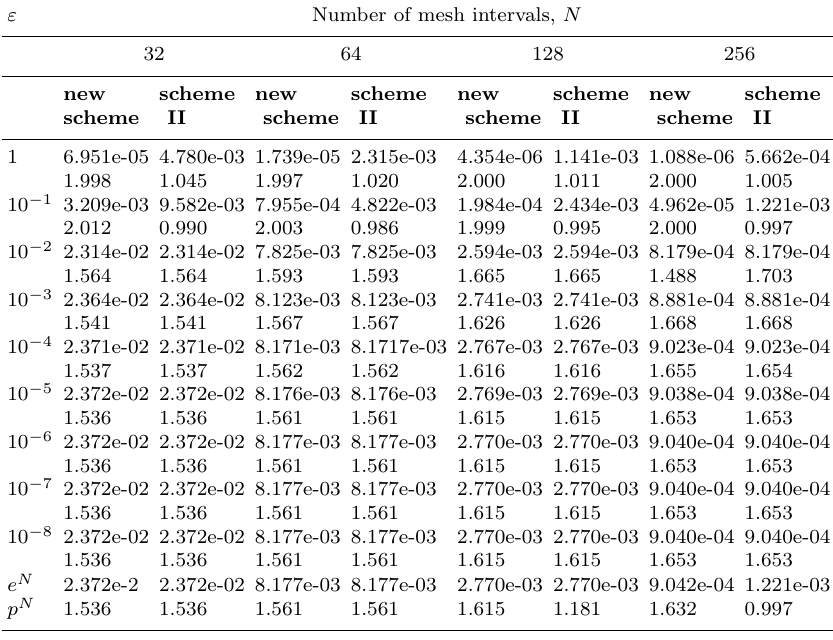
Table 1. Maximum point-wise errors and order of convergence for Example